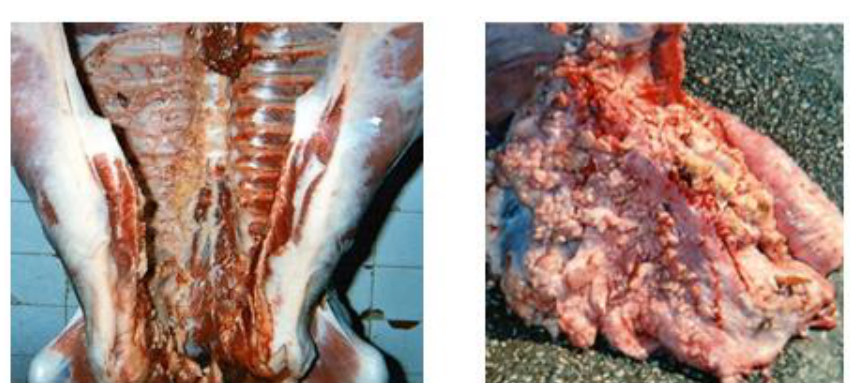
Figure 4. Tuberculosis (Nodularized or miliary appearance with pasty caseiform necrosis).